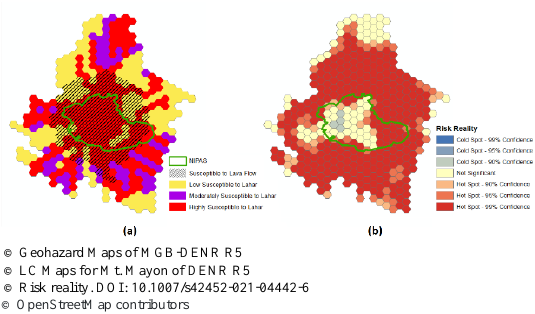
Figure 7 . Source of gravel & sand vs. Risk reality Figure 8 & 9 disclose the following: i) not all the lava and lahar